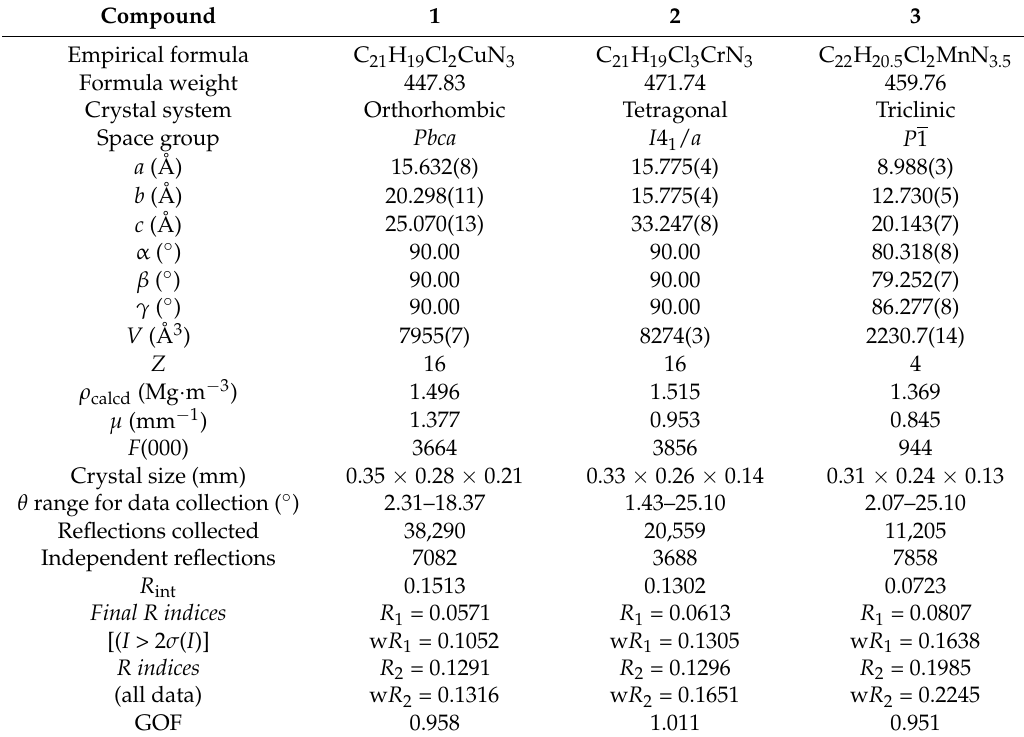
Figure 1. The molecular structure and crystallographic numbering scheme for complex 1 . Table 1. Crystal data for complexes 1 – 3.